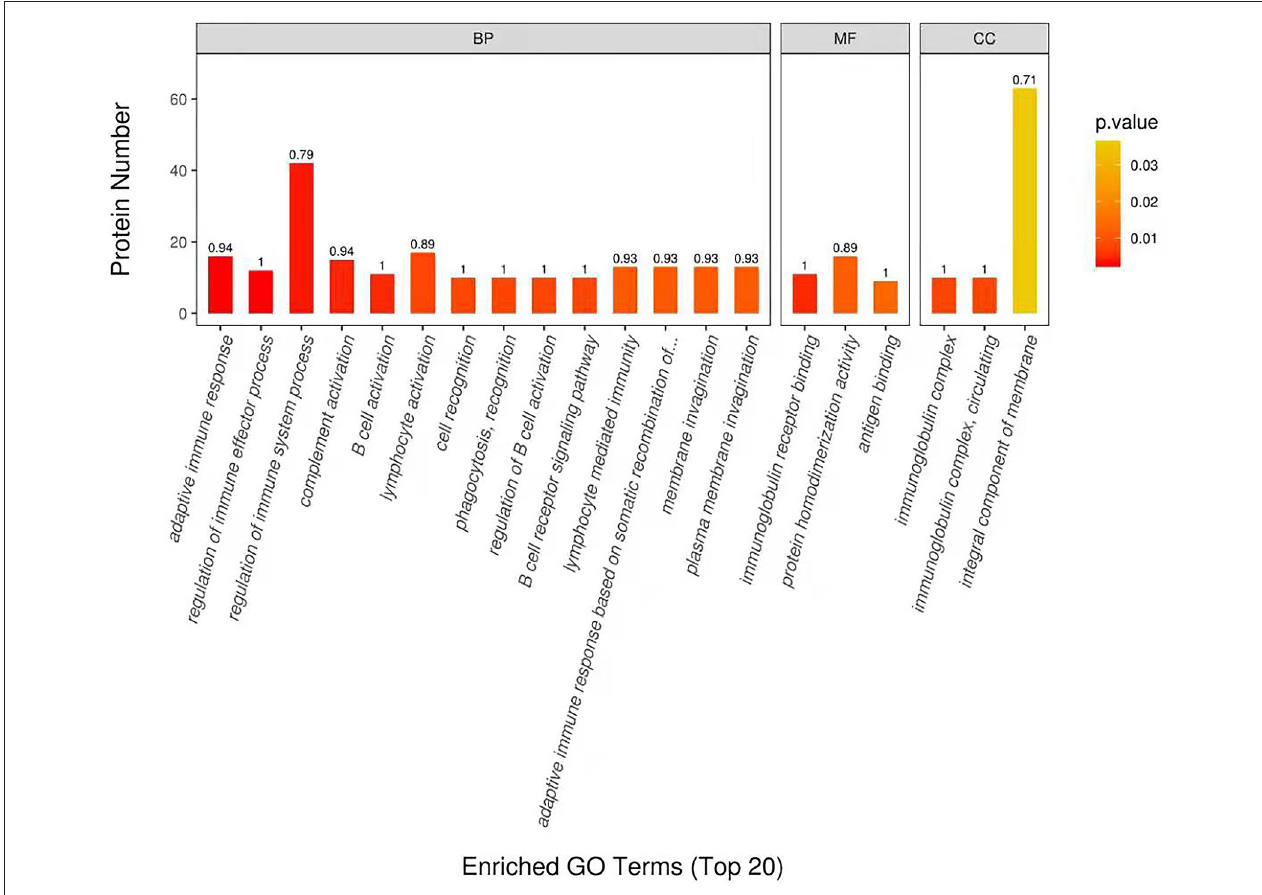
FIGURE 3 | Enriched Gene Ontology (GO) Terms of the DEP in DM and HM group. GO enrichment of DEP on three categories. BP, biological processes; MF, molecular functions; CC, cellular components; DEP, differentially expressed proteins; DM, donkey milk; HM, human